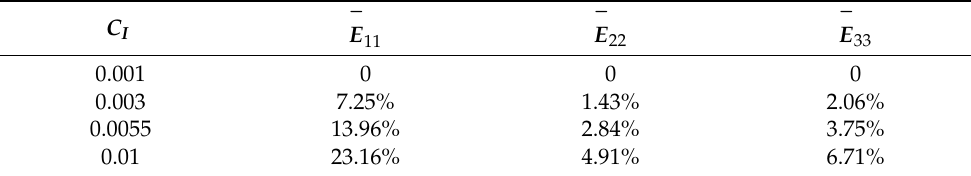
Table 5. PRDs of computed mean axial elastic constants of 13 wt.% CF/ABS deposited bead. ¯ C I E 11